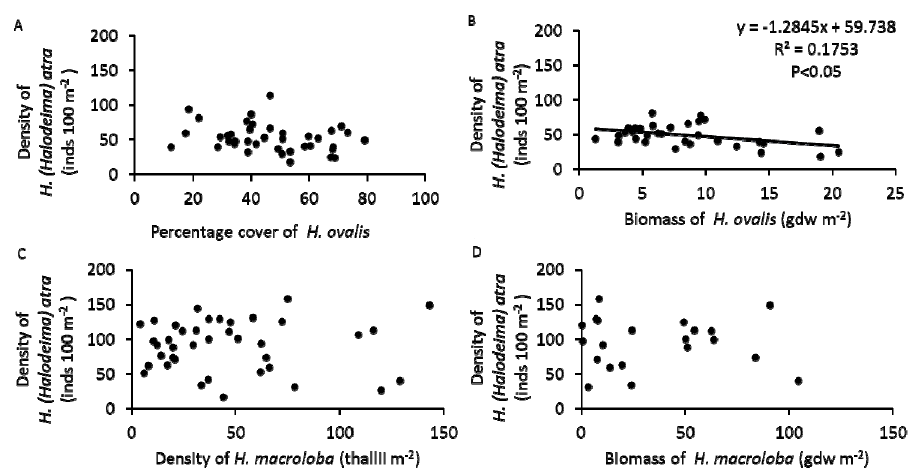
Figure 5. Relationship between density of H. atra and abundance of macrophytes: ( A ) percentage cover of H. ovalis ; ( B ) aboveground biomass of H. ovalis ; ( C ) density of H. macroloba ; and ( D ) aboveground biomass of H. macroloba .